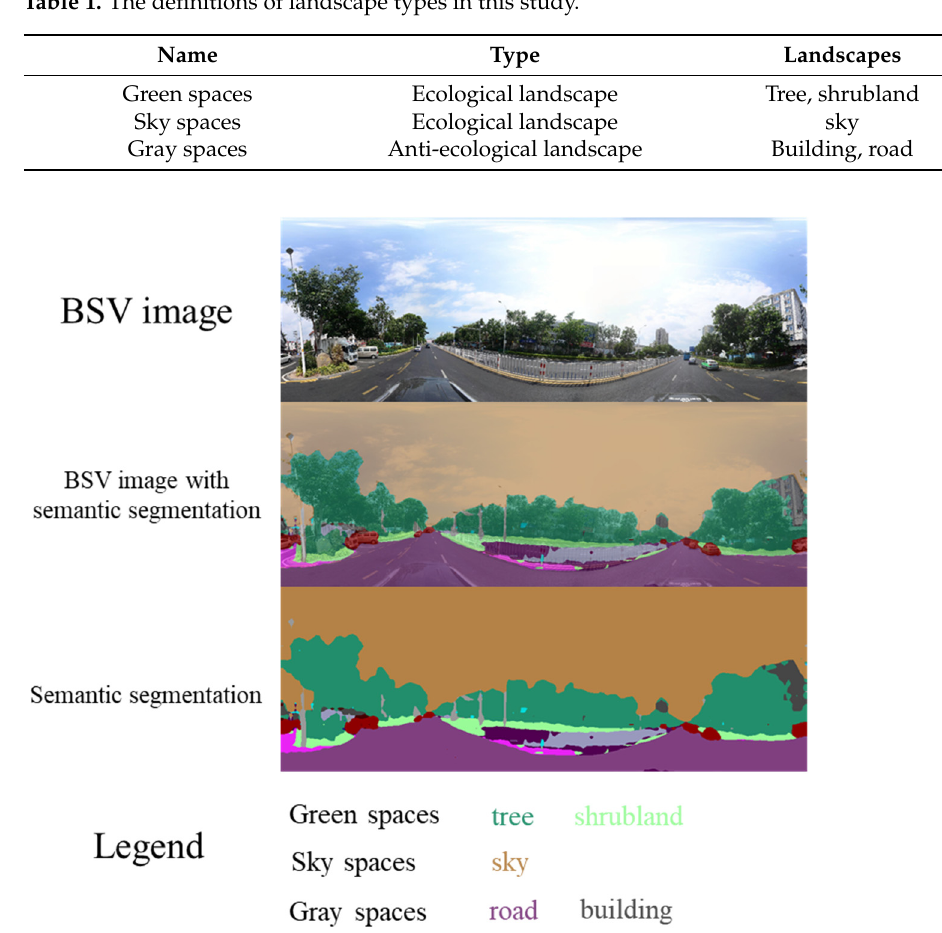
Table 1. The definitions of landscape types in this study.